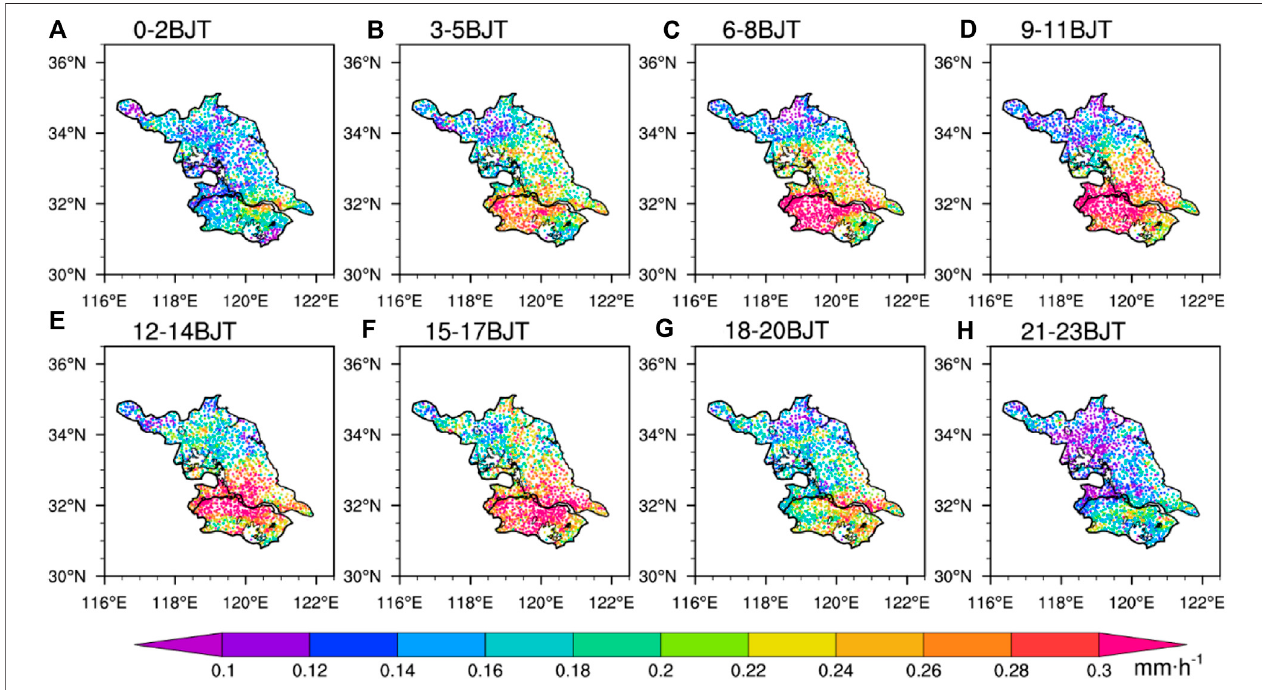
FIGURE 5 | Spatial distributions of the 3-hourly mean PA over Jiangsu province in warm season averaged over 2013 – 2017. (Figures A-H separately represents every 3 hours from 0-24).